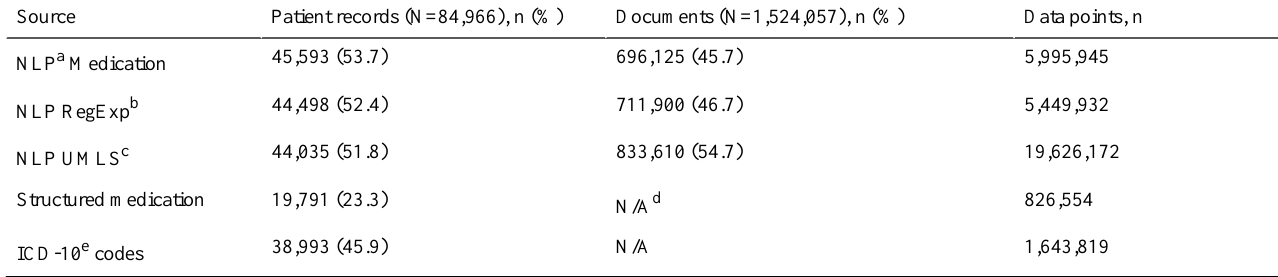
Table 1. Description of the information extracted using the NLP pipeline in the EDS-COVID cohort